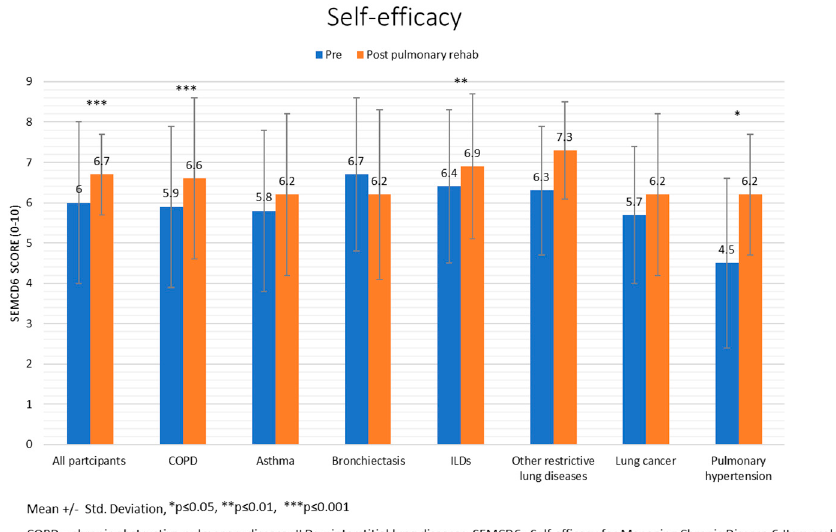
Figure 2. Self-efficacy pre-post Pulmonary Rehabilitation program.